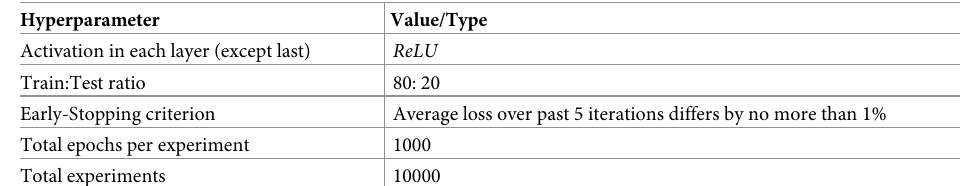
Table 1. Iris ANN classifier details.